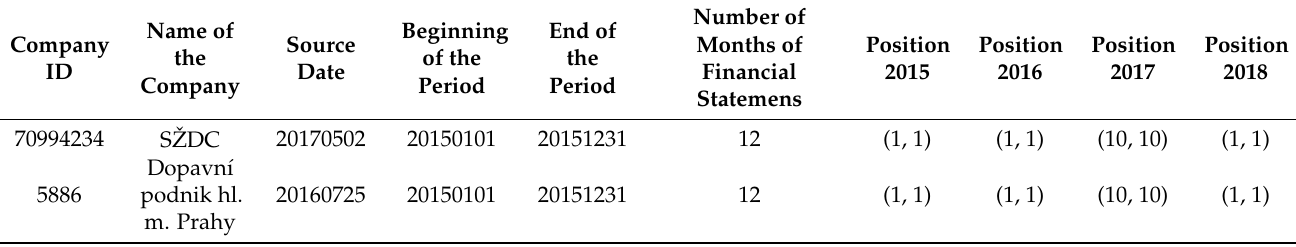
Table 11. Change of clusters—(1, 1) replaced by (10, 10).